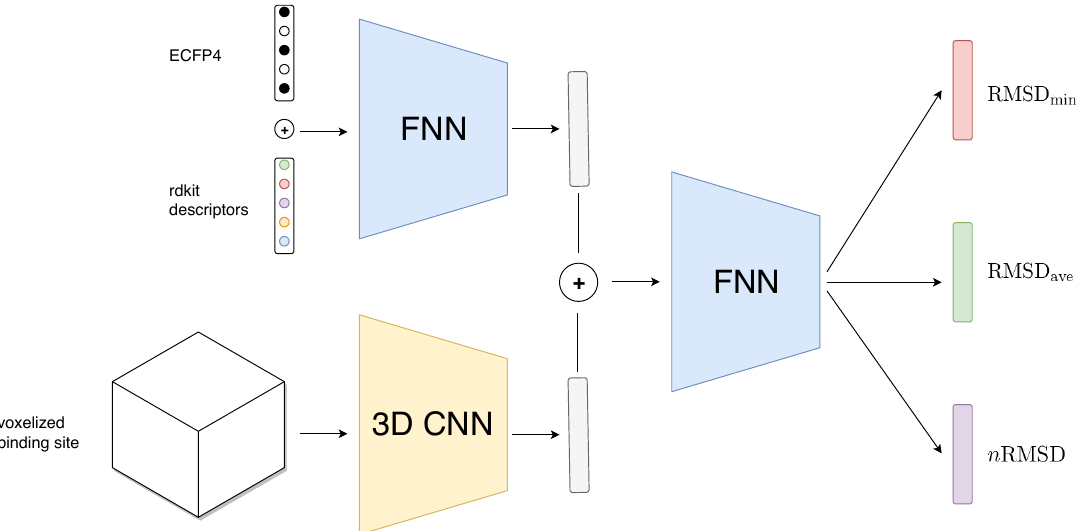
Figure 4. Schema of the proposed architecture in this work. A fully connected neural network handles ECFP4 fingerprints and descriptors computed from RDKit while a 3D-convolutional neural network processes a voxelized representation of the protein binding site. Latent space from both inputs is then concatenated and fed into further fully connected layers that predict the three outputs of interest per docking